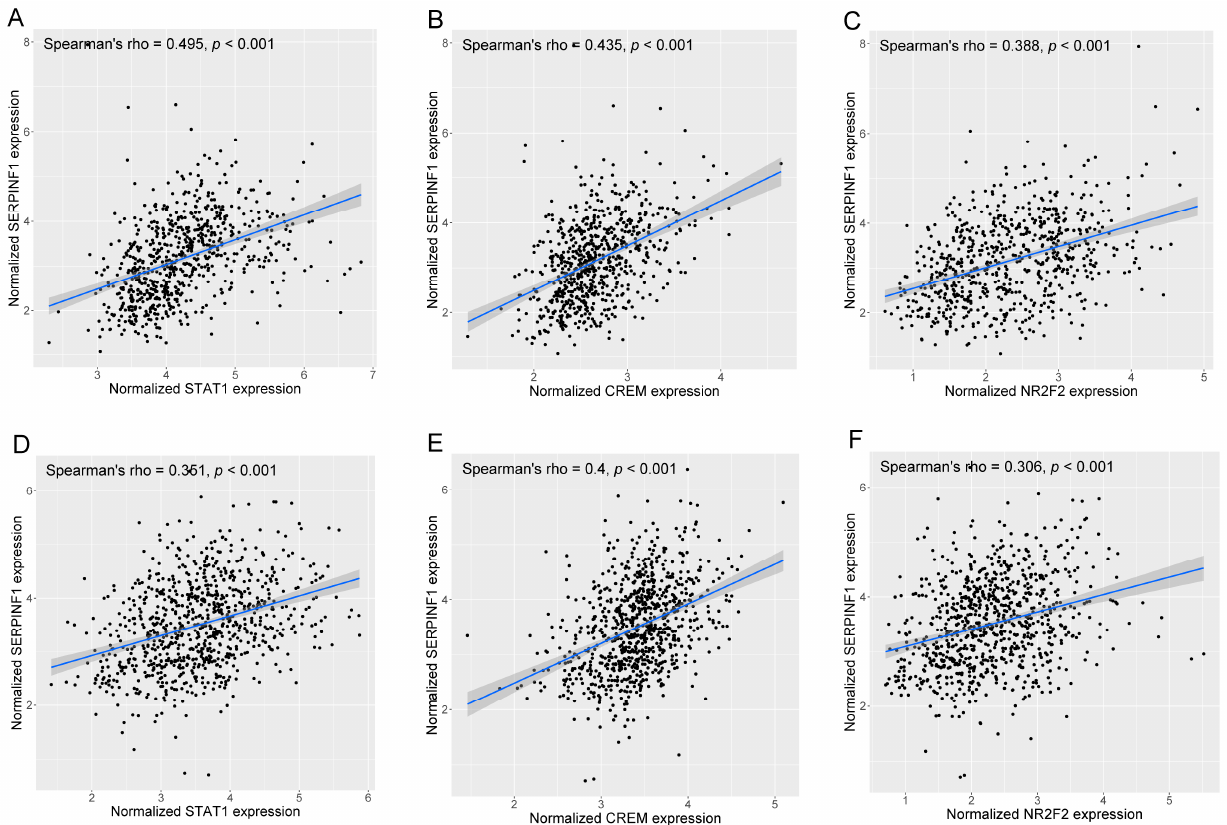
Figure 8. The correlations between the expression of SERPINF1 and that of STAT1, CREM, and NR2F2 in TCGA ( A – C ) and CGGA ( D – F ).